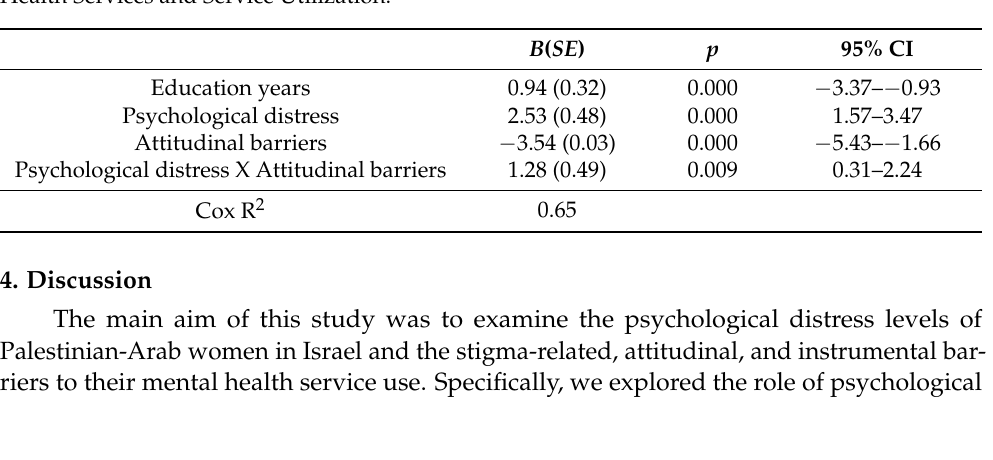
Reported Not Reported Using Mental Using Mental Range Health Services Health Services ( n = 55) ( n = 91)